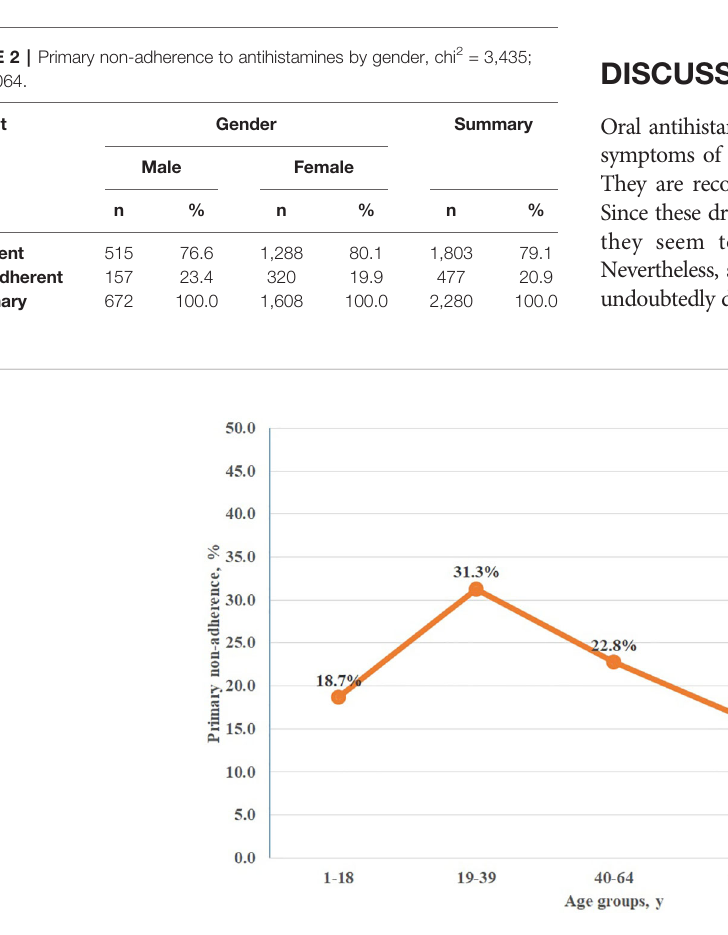
FIGURE 1 | Primary non-adherence to orally administered antihistamines among age groups in Poland. chi 2 = 41,810; p =